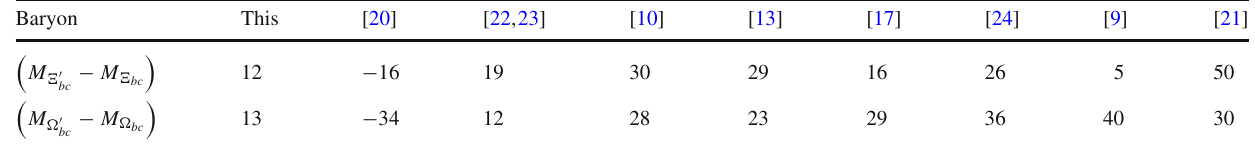
− M (cid:2) ) and ( M − M (cid:3) ) in MeV. The unprimed (cid:2) (cid:3) (cid:2) bc bc bc bc